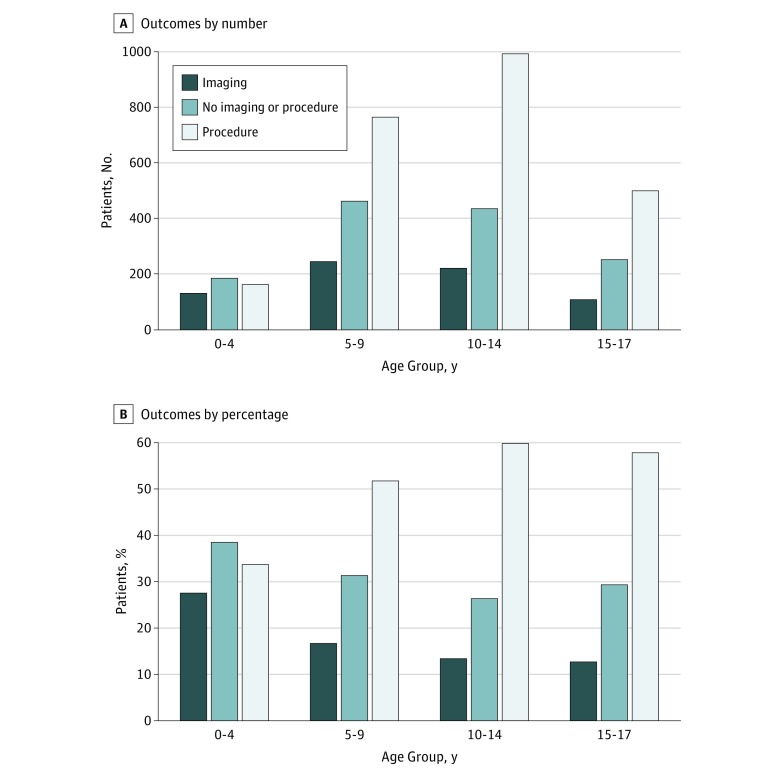
Outcomes by Age GroupNumber (A) and percentage (B) of outcomes at the receiving hospital for patients in 4 age groups.